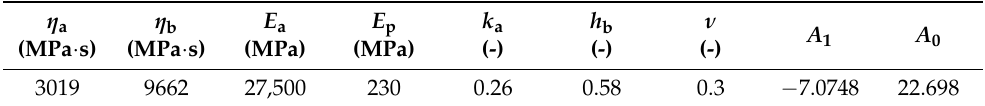
Table 8. Huet-Sayegh model parameters, Poisson’s ratio and AC 16 W 45/80-80 HiMA fatigue curve coefficients at T = 10 ◦ C.